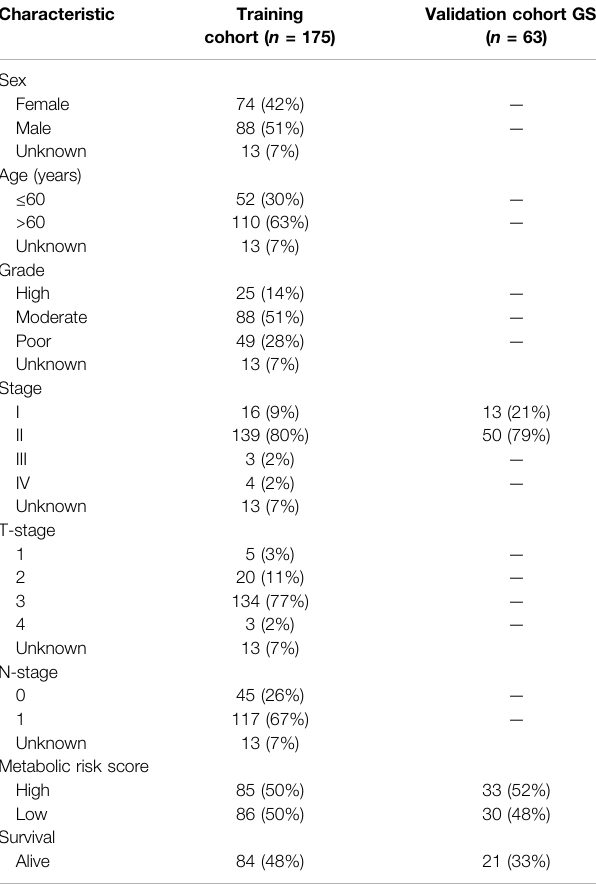
TABLE 2 | Clinical covariates of the training and validation cohorts.